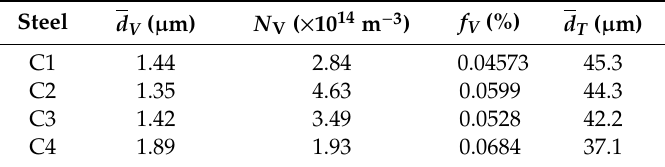
Figure 1. Inclusion size distribution for the four steel alloys. Table 2. Statistics of the inclusions in the steel ingots.